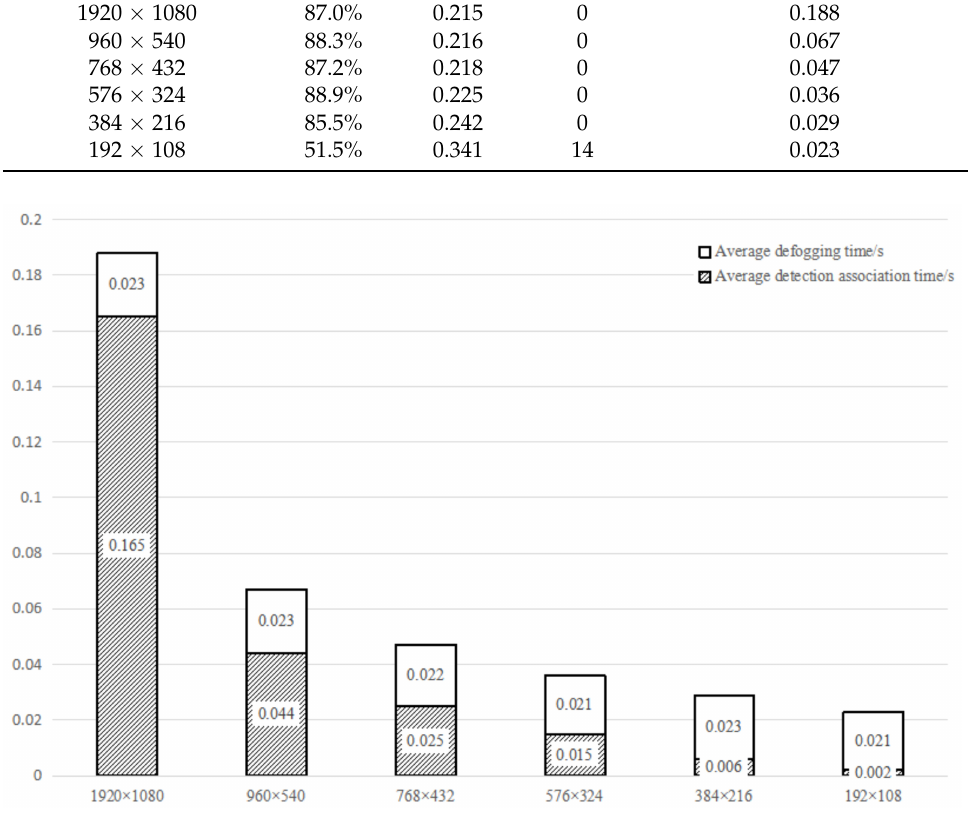
Figure 16. Comparison of tracking time with different compression